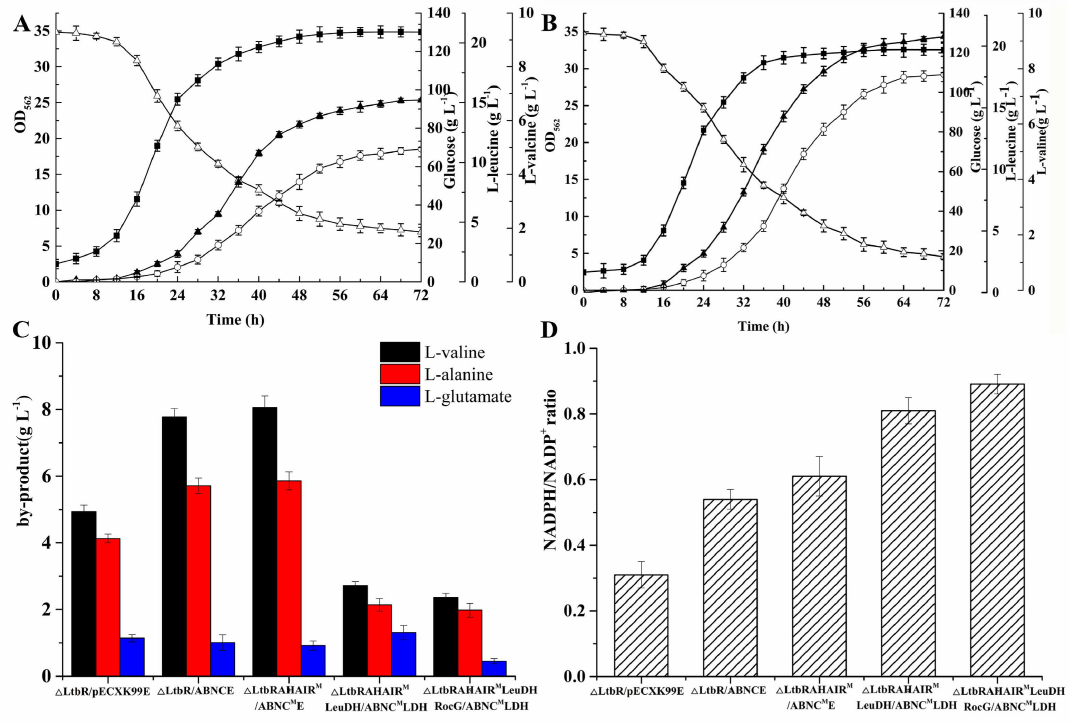
Figure 2. Comparison of the di ff erent C. glutamicum strains during cultivation in shake-flasks with the fermentation medium, to test the e ff ect of inserting leuAilvBNCE . ( A ) ∆ LtbR / pECXK99E (pECXK99E was used here as a control plasmid), ( B ) ∆ LtbR / ABNCE, ( C ) by-products, and ( D ) NADPH / NADP + ratio. Solid squares—OD 562 , hollow triangles—glucose, solid triangles— l -leucine: hollow circles— l -valine. The data represent the mean values and standard deviations obtained from three independent